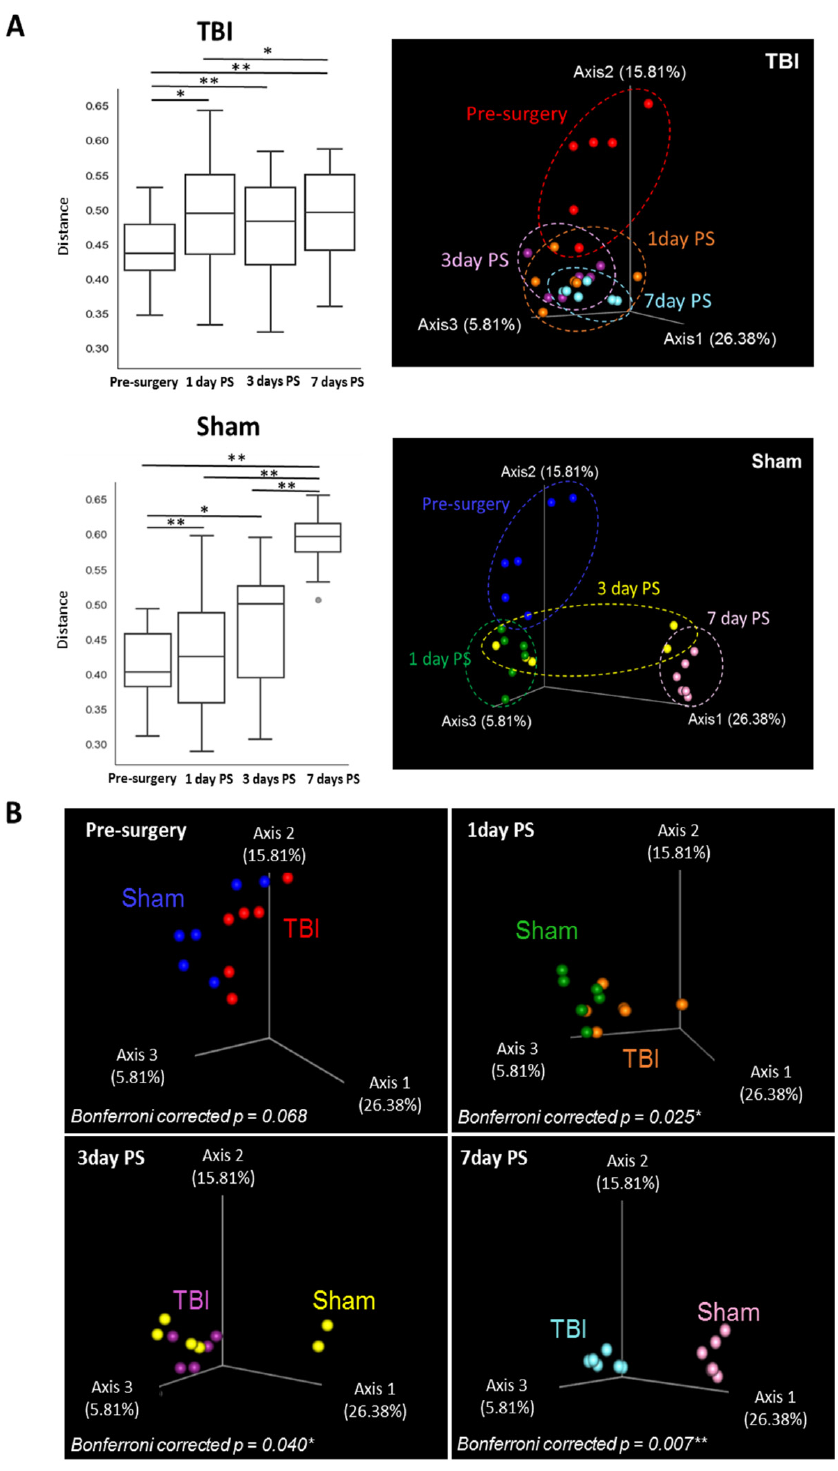
Figure 2. Beta diversity of the oral microbiome was different between TBI and sham piglets. Un- weighted UniFrac matrix distance was used to evaluate the microbial pattern within and between groups during the acute stage of TBI. ( A ) Both TBI ( n = 6) and sham ( n = 6) groups showed significant changes in different beta diversity post-surgery compared to pre-surgery. ( B ) Distinct microbial patterns were observed between the TBI and sham groups at 1, 3, and 7 days PS, with the most apparent difference at 7 days PS. Bonferroni corrected p -value: * p < 0.05, ** p < 0.01. TBI, traumatic brain injury; PS,